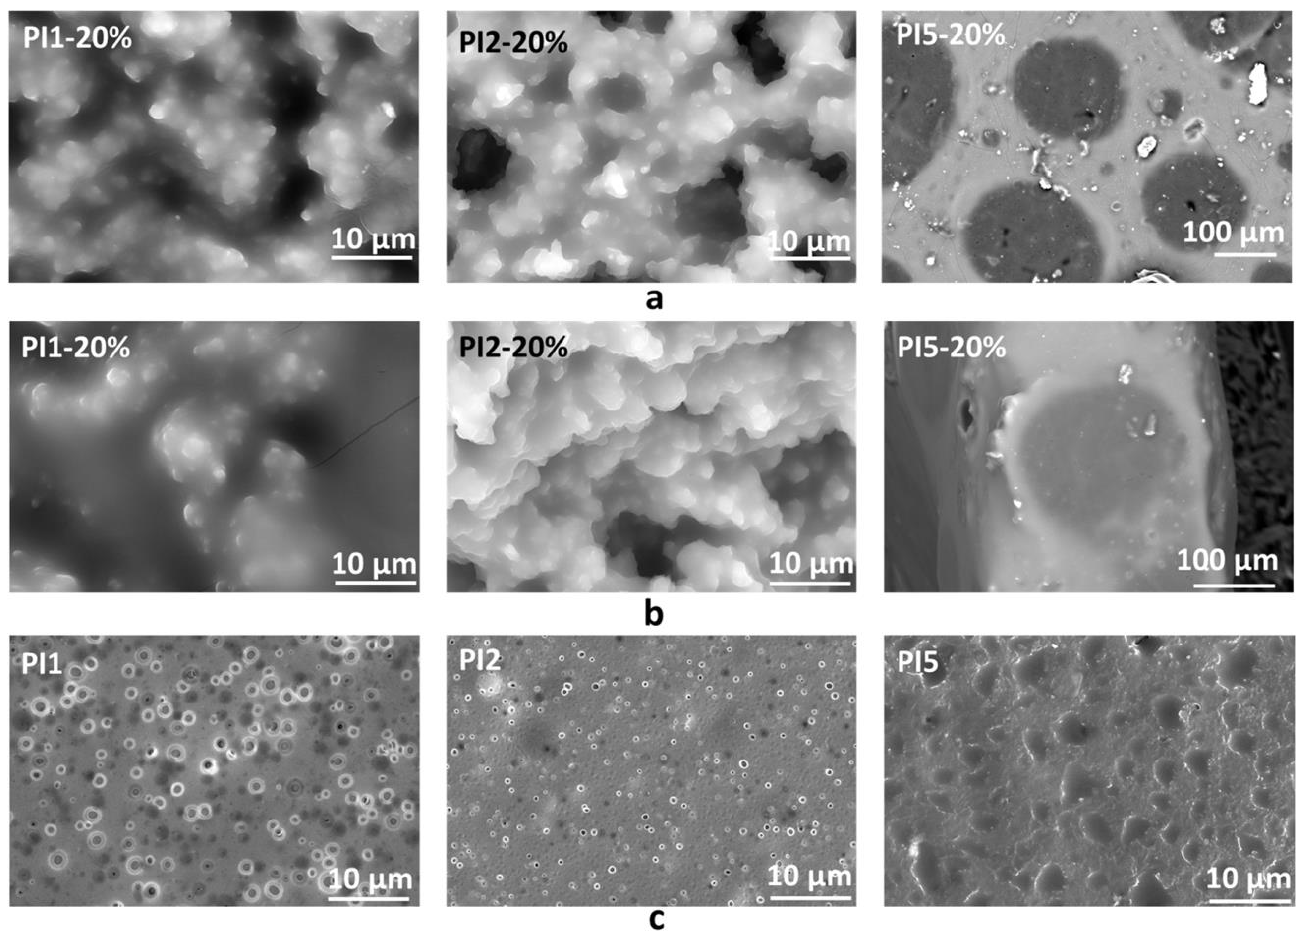
Figure 1. SEM images of the PIa-b siloxane-based elastomer films: ( a )—on the surface, ( b )—in section (recorded by using Circular Back Scattered Detector, CBS); ( c )—film surface of the initial PIa samples (recorded by using Everhart Thornley Detector, ETD).